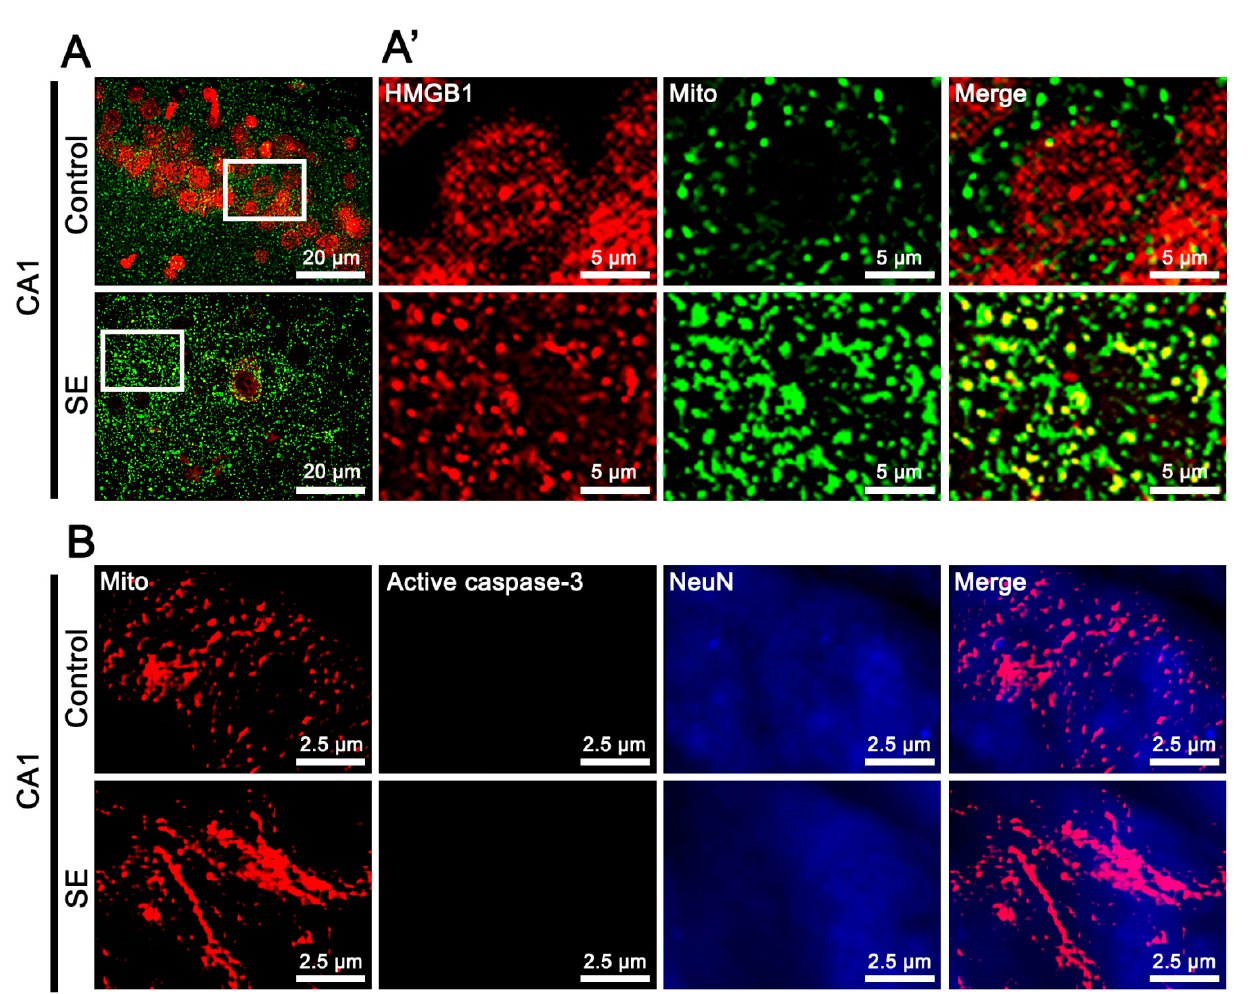
Figure 2. Mitochondrial accumulations of HMGB1 and active caspase-3 in neuron nuclei antigen (NeuN)-positive CA1 neurons following SE. ( A ) Translocation of HMGB1 from nucleus to mitochondria in CA1 neurons following SE. ( A’ ) shows high magnifications of rectangles in the left panels. ( B ) Absence of mitochondrial accumulation of active caspase-3 in CA1 neurons following SE.